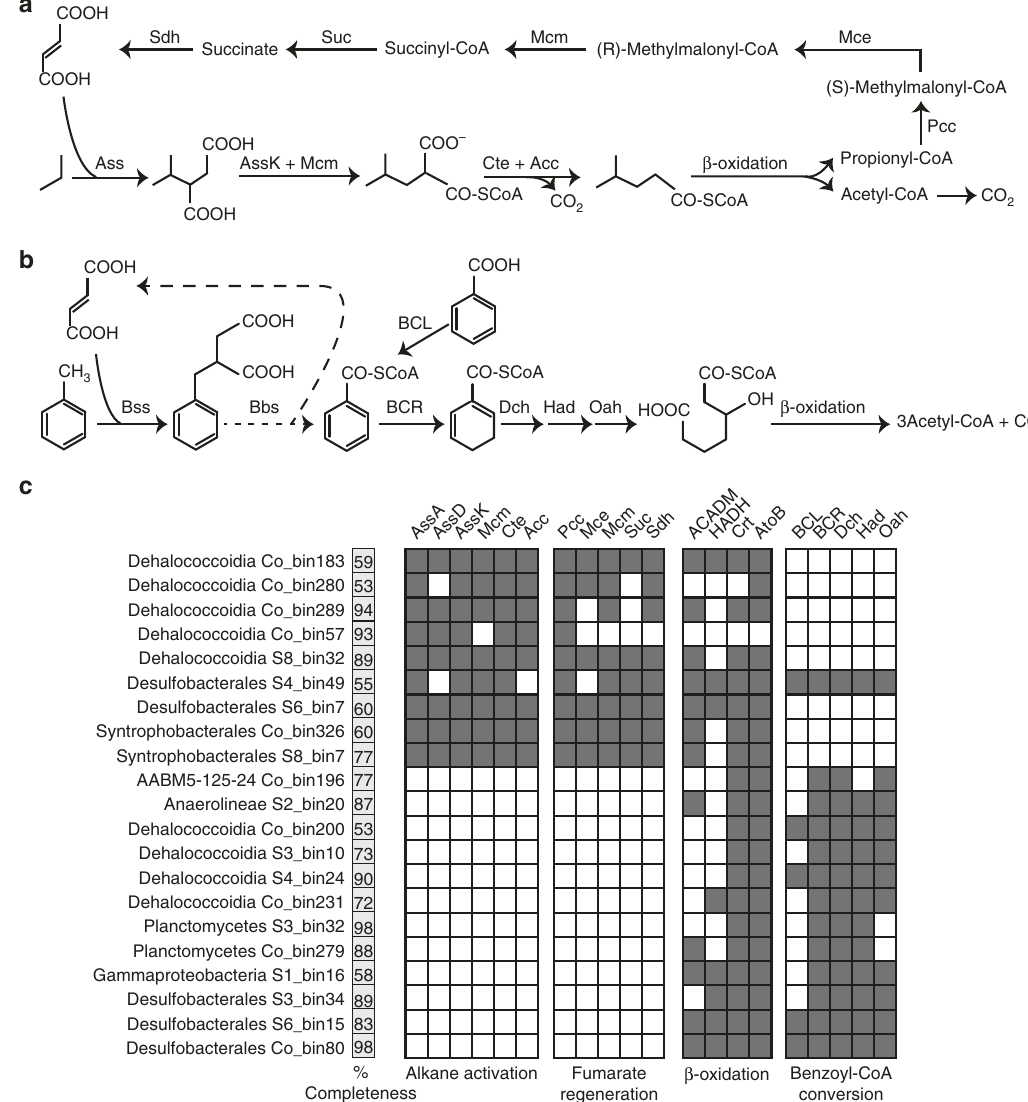
Fig. 6 Predicted metabolic models for anaerobic degradation of alkanes and benzoate based on bacterial MAGs harboring assA and bcr genes. Proposed metabolic pathways for anaerobic degradation of a propane and b toluene via addition to fumarate. Propane and toluene here serve as examples for illustrating anaerobic degradation of alkane and aromatic hydrocarbons more generally. c Occurrence of protein encoding genes involved in these pathways in bacterial MAGs, as a presence/absence ( fi lled/white squares) matrix. Genome completeness (%) for each MAG as estimated by CheckM is indicated. Details on the annotation of the enzymes are presented in Supplementary Data 11 and